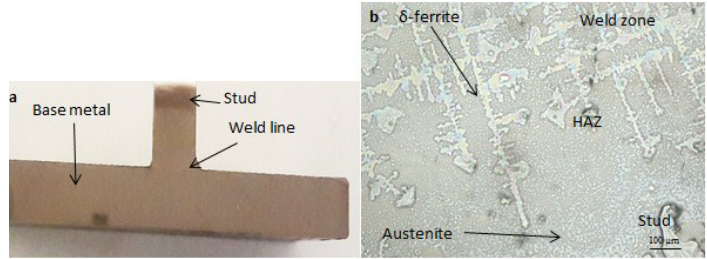
Figure 2. Specimen 400-0.15-3-2: ( a ) cross-section image and ( b ) microstructure.